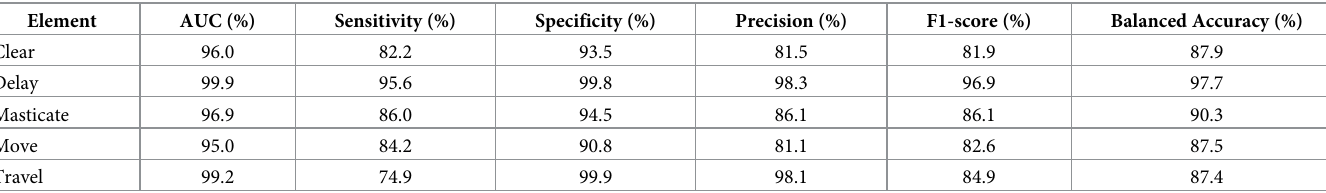
Table 3. Activity recognition performance metrics for the best performing classification model (50 Hz sampling rate, 10 second window, 90% widow overlap). Element